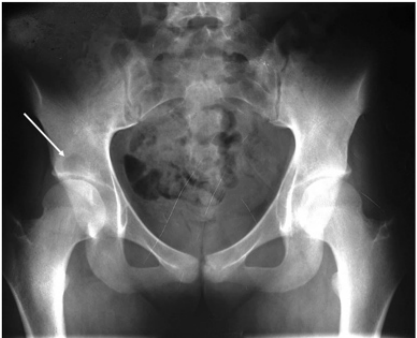
Figure 1. Pelvic AP radiography showing a well-delimited lesion (arrow) in the right supraacetabular area. The lesion is osteolytic without periosteal reaction or soft tissue invasion. Our clinical examination revealed painful mobilities of the right hip, without evi- dence of a palpable mass. Hip mobilities were normal, except the external rotation which was limited to 25° and the abduction to 30° (active and passive). Normal walking was possible without any sign of gluteus medius insufficiency. The laboratory blood tests and urine analysis results were normal.